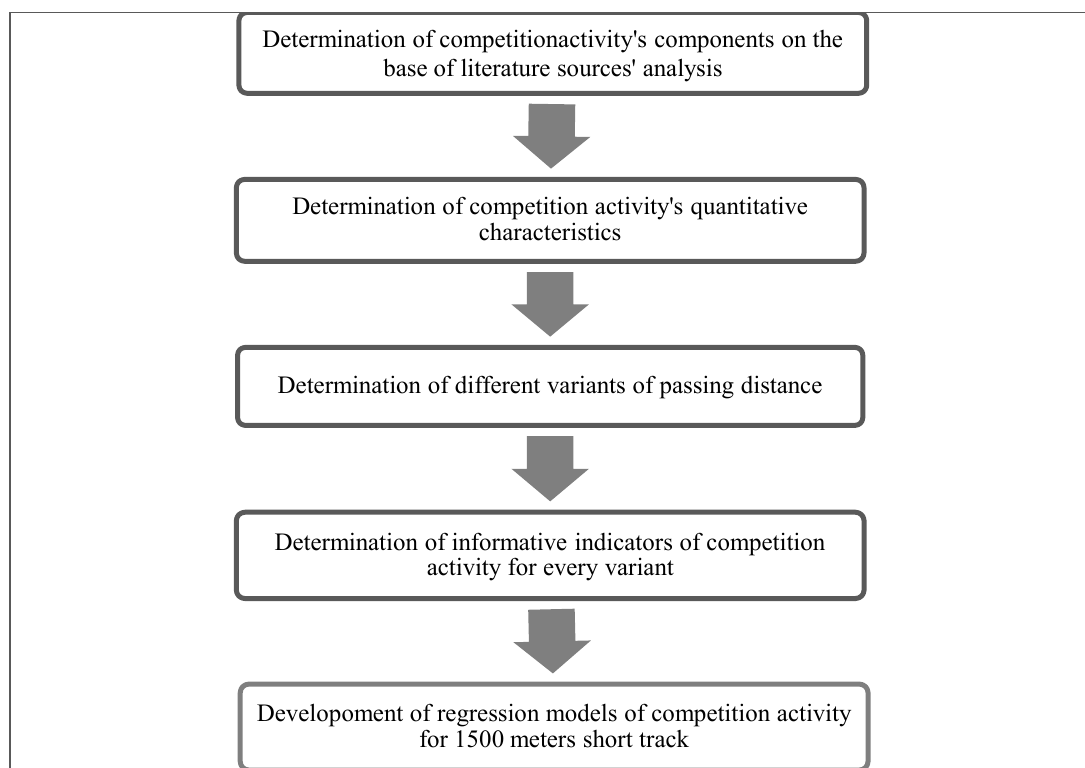
Fig. 1. Algorithm of building of competition activity’s regressive models for 1500 meters short track